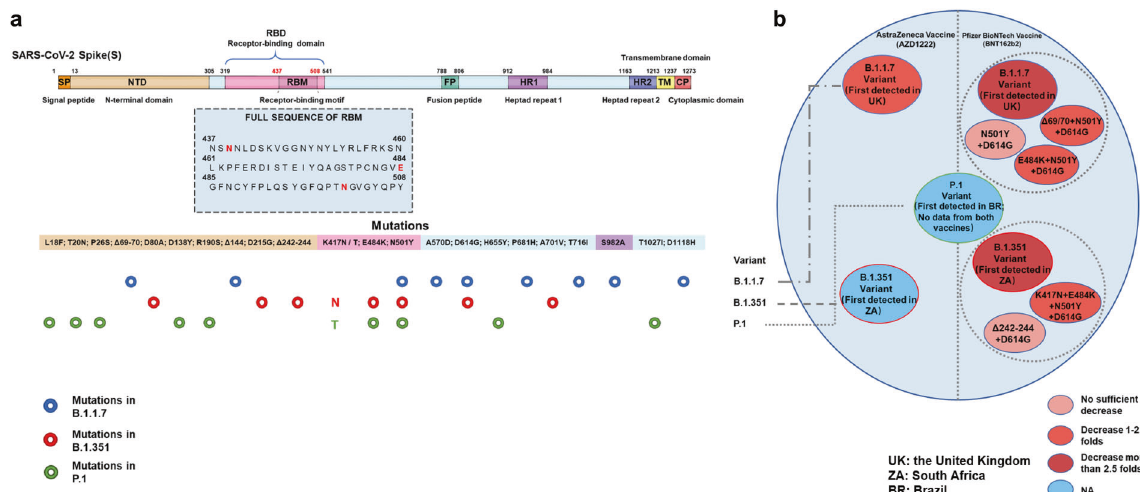
Fig. 1 A schematic illustration of SARS-CoV-2 S protein sequence, prevalent mutations in current circulating SARS-CoV-2 variants, and the neutralization ef fi ciency change of two mRNA vaccines — vaccine AZD1222 and vaccine BNT162b2. a RBM sequence (amino acid 437 – 508) containing N439K, E484K, and N501Y is a highly variable region, and SARS-CoV-2 spike protein mutations of three major circulating variants B.1.1.7, B.1.351, and P.1 are displayed, which can be tracked online (https://covariants.org/, https://cov-lineages.org/). b The neutralization ef fi ciency of two major vaccines — vaccine AZD1222 and vaccine BNT162b2 to major circulating variants and potentially important variants of SARS-CoV-2 are exhibited. The neutralizing activity of the vaccine sera against different variants are shown in different colors from light red (no suf fi cient decrease), lycopene (decrease between 1.5-fold and 2.5-fold), to wine red (decrease more than